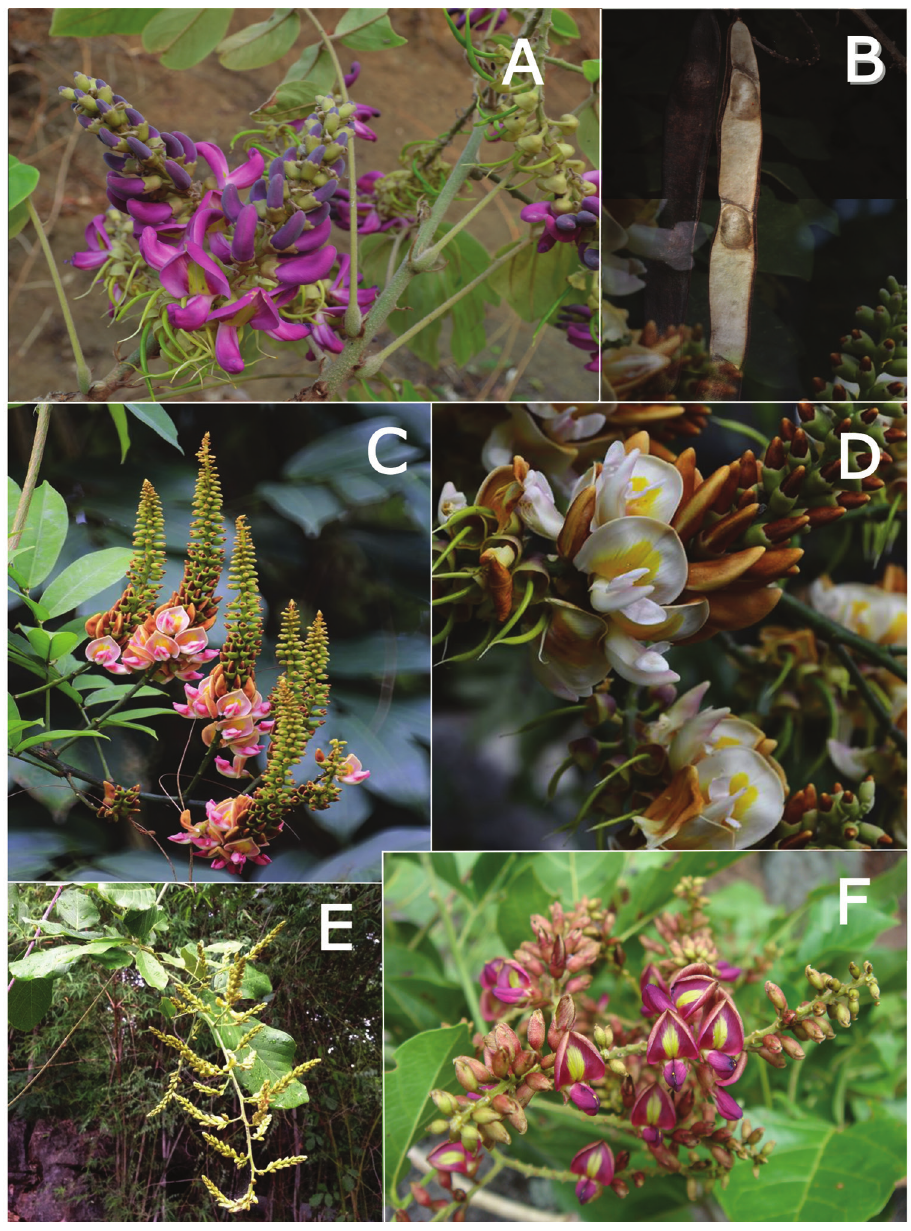
Plate 1. Endosamara, Sigmoidala and Kanburia . A, B Endosamara racemosa, Thailand, Sakon